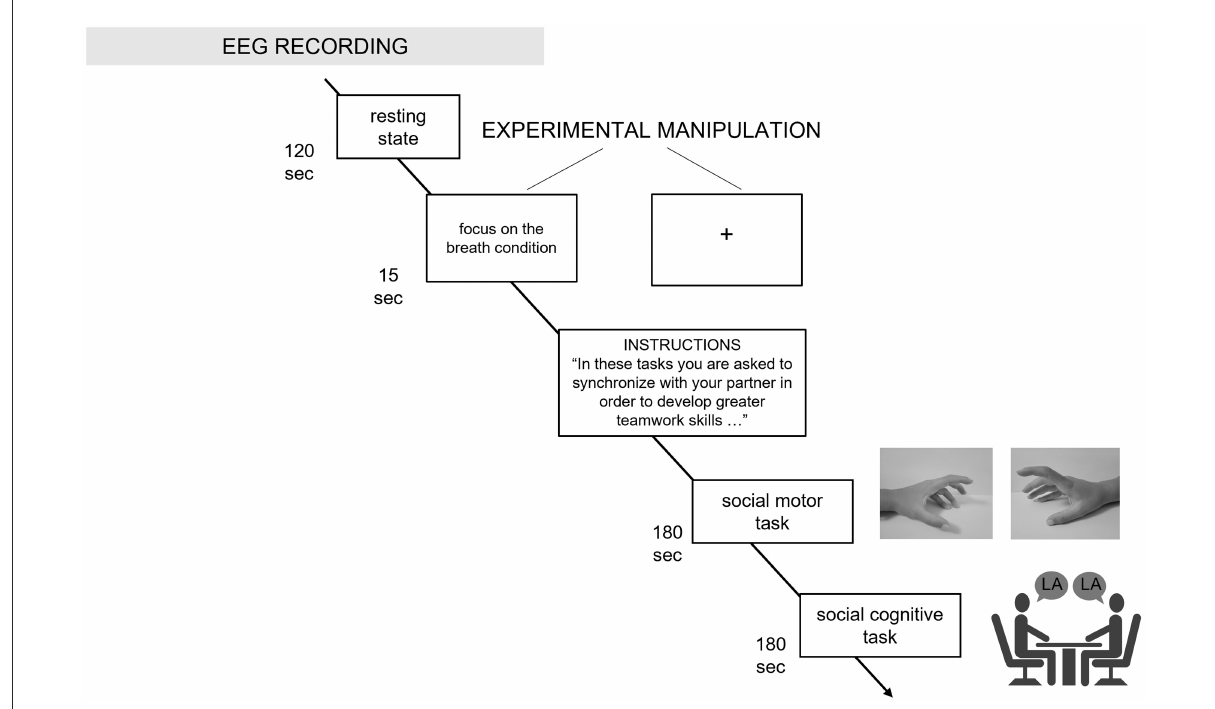
FIGURE1 Experimental procedure. The procedure and the duration of each experimental step is graphically described in the figure, along with the baseline, experimental instructions, social motor, and social cognitive synchronization tasks.